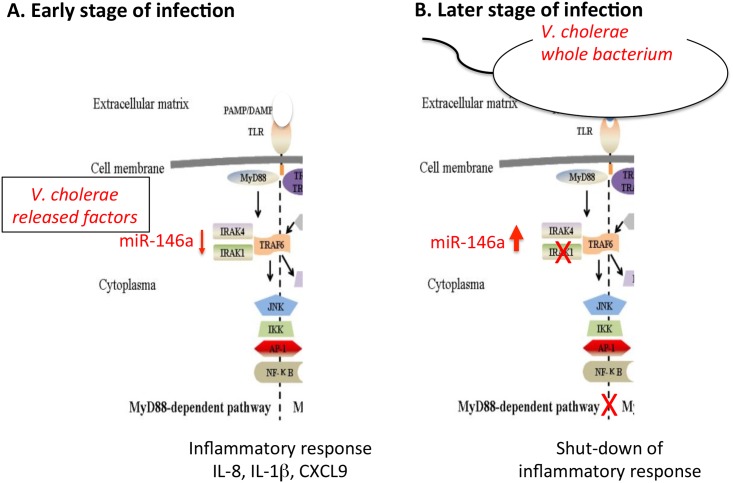
Hypothetical scenario of what is happening at the epithelial lining of the small intestine at the acute phase of V. cholerae infection.V. cholerae is a Gram(-), flagellated bacterium that secretes several soluble factors, e.g. cholera toxin and V. cholerae cytolysin, and release outer-membrane vesicles (OMVs). The released components are all potential inducers of inflammatory responses. We hypothesize that the bacteria secrete these factors already in the gut lumen. Their soluble nature makes it possible for them to pass through the mucous layer, reach the epithelial surface and enter into the cytoplasm. The epithelial cells respond to this invasive attack by activating the IL-1β inflammasome and secretion of chemokines recruiting immune cells to the site, notably IL-8 a strong attractant for neutrophil granulocytes (A). The Vibrio cholerae bacterium is motile and can produce mucinases, hence it would be feasible for the bacteria to penetrate the mucous layer and reach the surface of the epithelial cells, although this process would be slower than for the released factors. Thus, the bacterium reaches the epithelium with an ongoing innate immune response. By binding to receptors at the cell surface the bacterium induces increased expression of microRNAs miR-146a and miR-155, thereby decreasing levels of IRAK1 with a consequent decreased inflammatory activity and decreased risk for the bacterium to be eliminated and increasing its chances to thrive at the epithelial lining and even get access to the bodily tissues (B). Figure adapted from: J Zhong, J-F Xu, P Yang, Y Liang, C-Y Wang (2011). Innate Immunity in the Recognition of β-Cell Antigens in Type 1 Diabetes, Type 1 Diabetes—Pathogenesis, Genetics and Immunotherapy, Prof. David Wagner (Ed.), ISBN: 978-953-307-362-0, InTech.